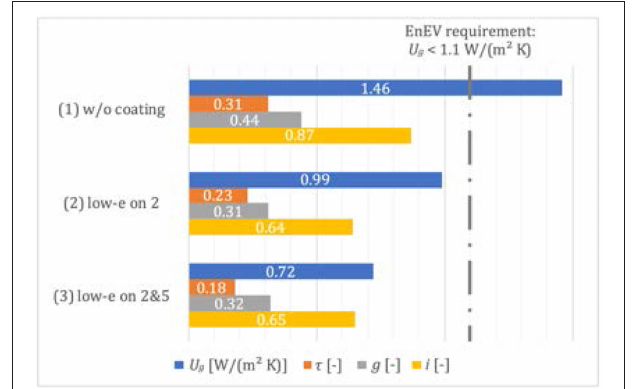
FIGURE 6 | Flow diagram for the device control strategy in long-term performance analysis.